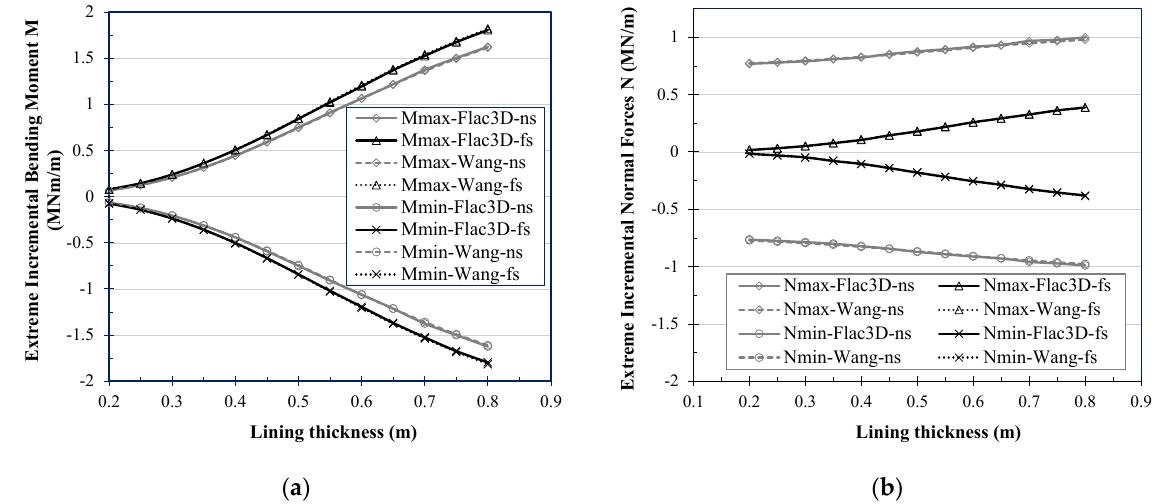
Figure 7. Effect of the lining thickness on the incremental internal forces in the circular tunnel lining. ( a ) Extreme incremental bending moments; ( b ) extreme incremental normal forces.